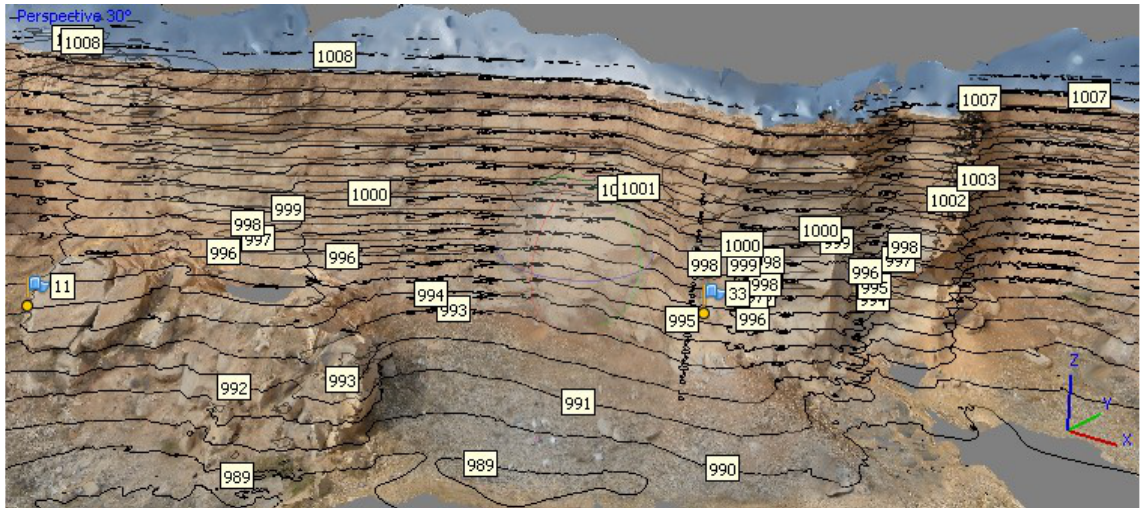
Figure 8. The cliff topography and height representation by contour line with one meter